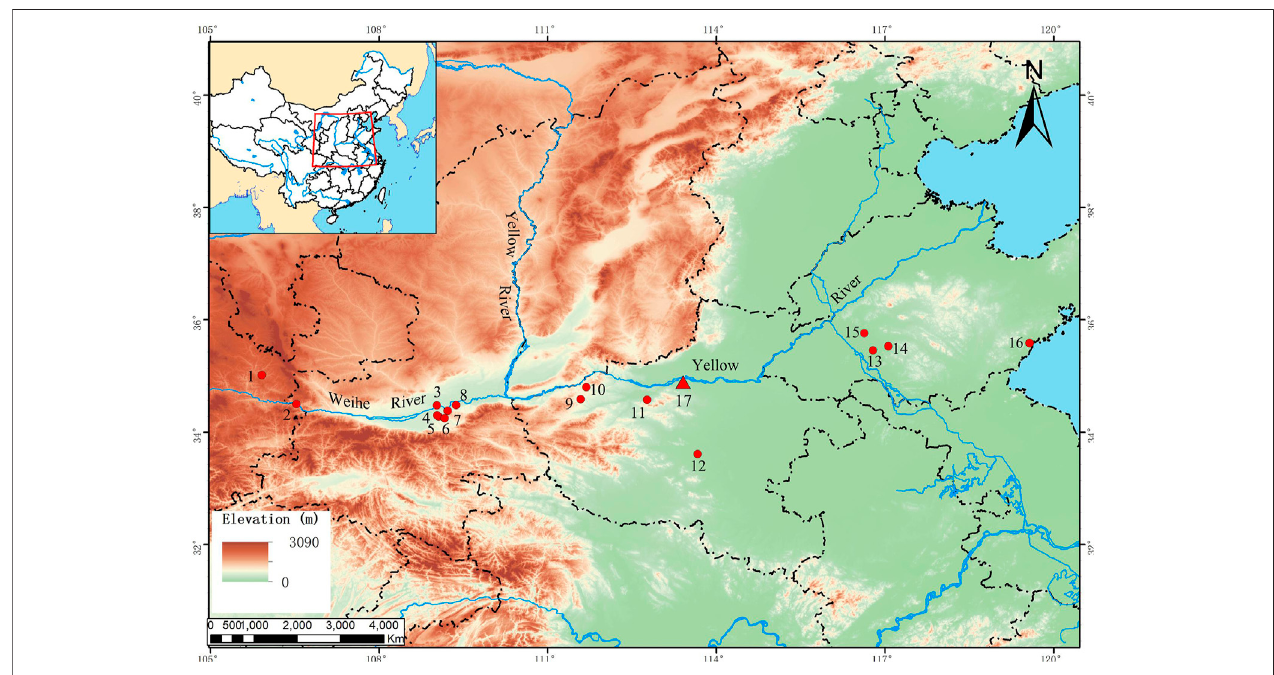
FIGURE1| LocationoftheQingtaisiteandotherrelatedarchaeologicalsitesinnorthChina.1)Dadiwan;2)Guantaoyuan;3)Yangguanzhai;4)Mijiaya;5)Banpo;6) Xinjie; 7) Jiangzhai; 8) Lingkou; 9) Xipo; 10) Dingcun; 11) Huizui; 12) Jiahu; 13) Wangyin; 14) Xixiahou; 15) Dongjiabai; 16) Liangchengzhen; 17) Qingtai.